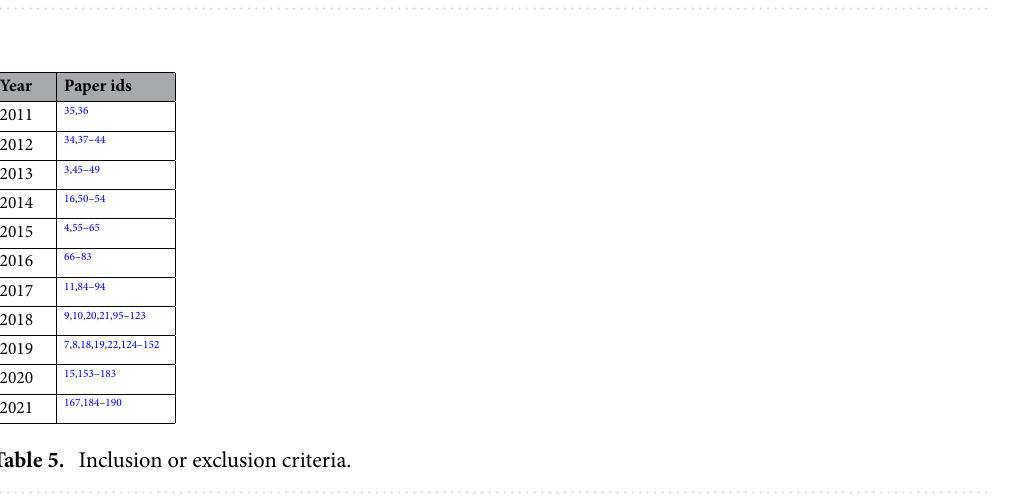
Figure 9. Evolution of database by number of articles by type.